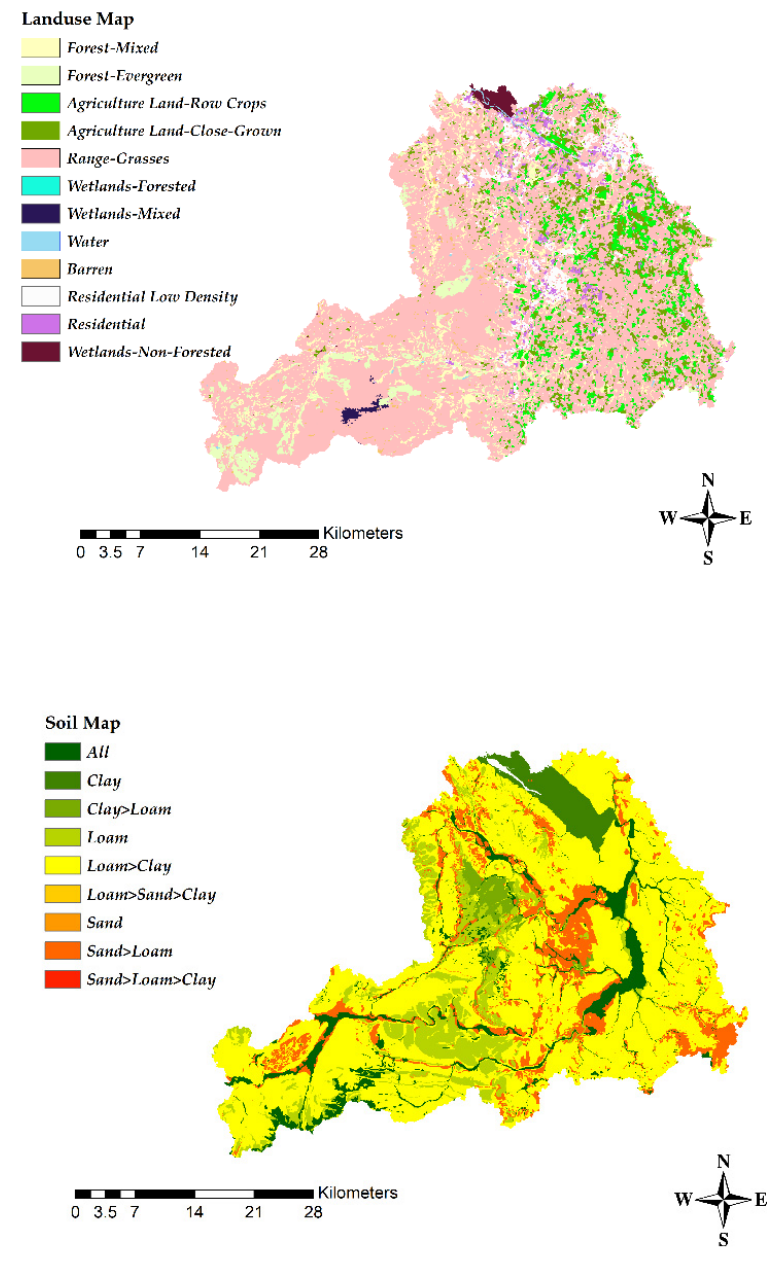
Figure 7. Land-use and soil maps in the Dee River basin.